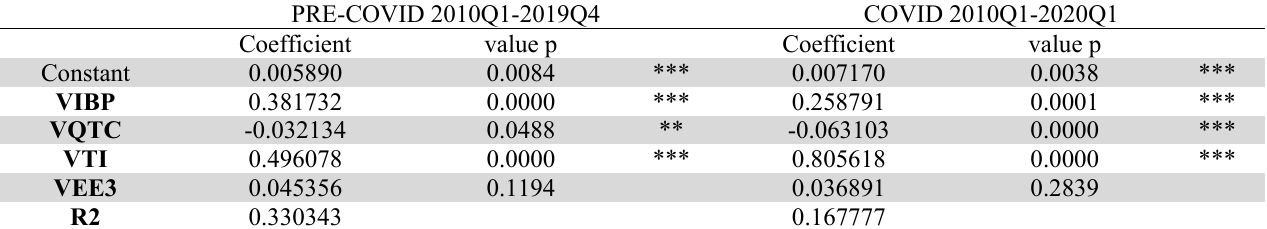
Fig. 1. Var % Fixed gross investment - Var % Tobin´s q Consumption